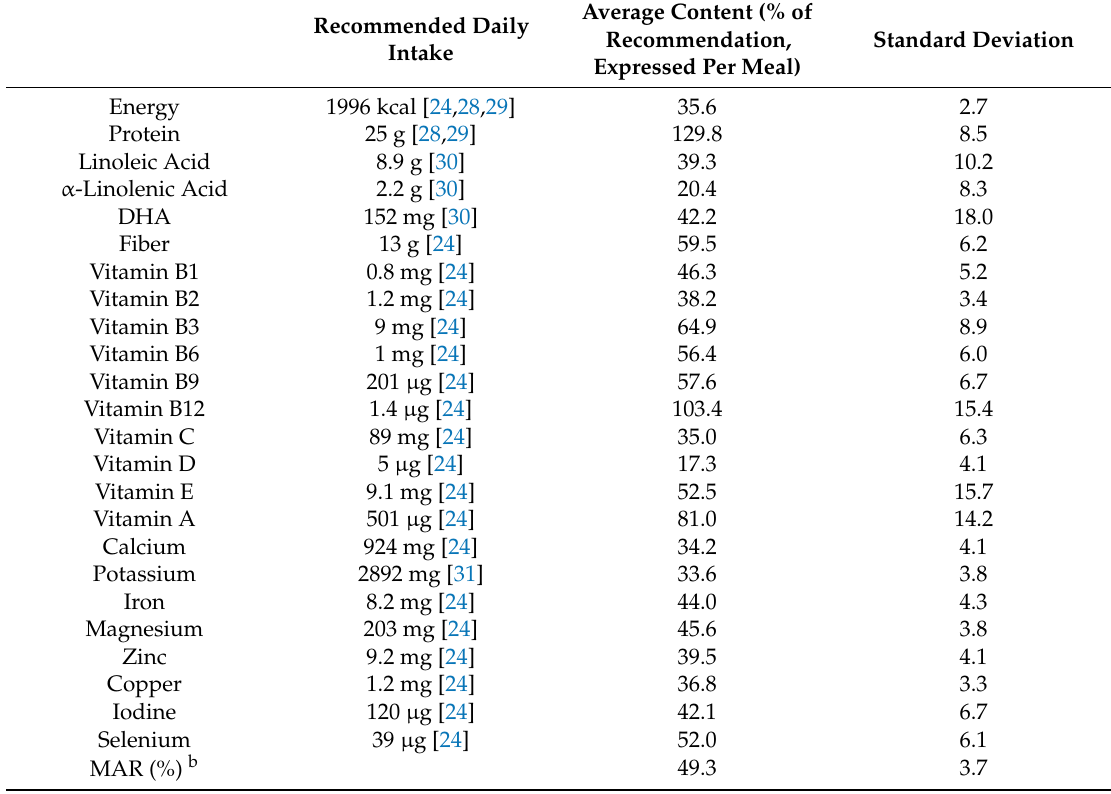
Table 2. Recommended daily intakes of energy and nutrients (proteins, essential fatty acids (FAs), fiber, vitamins and minerals) included in the calculation of the Mean Adequacy Ratio (MAR) and percentages of these recommendations in the observed series of 20 meals ( N = 40), expressed per meal a